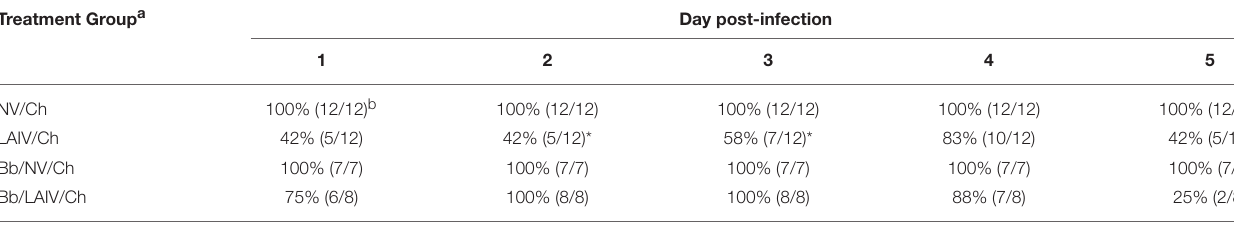
TABLE 2 | Percent of pigs in each group positive for IAV in nasal swabs on the indicated day post-infection. Treatment Group a Day